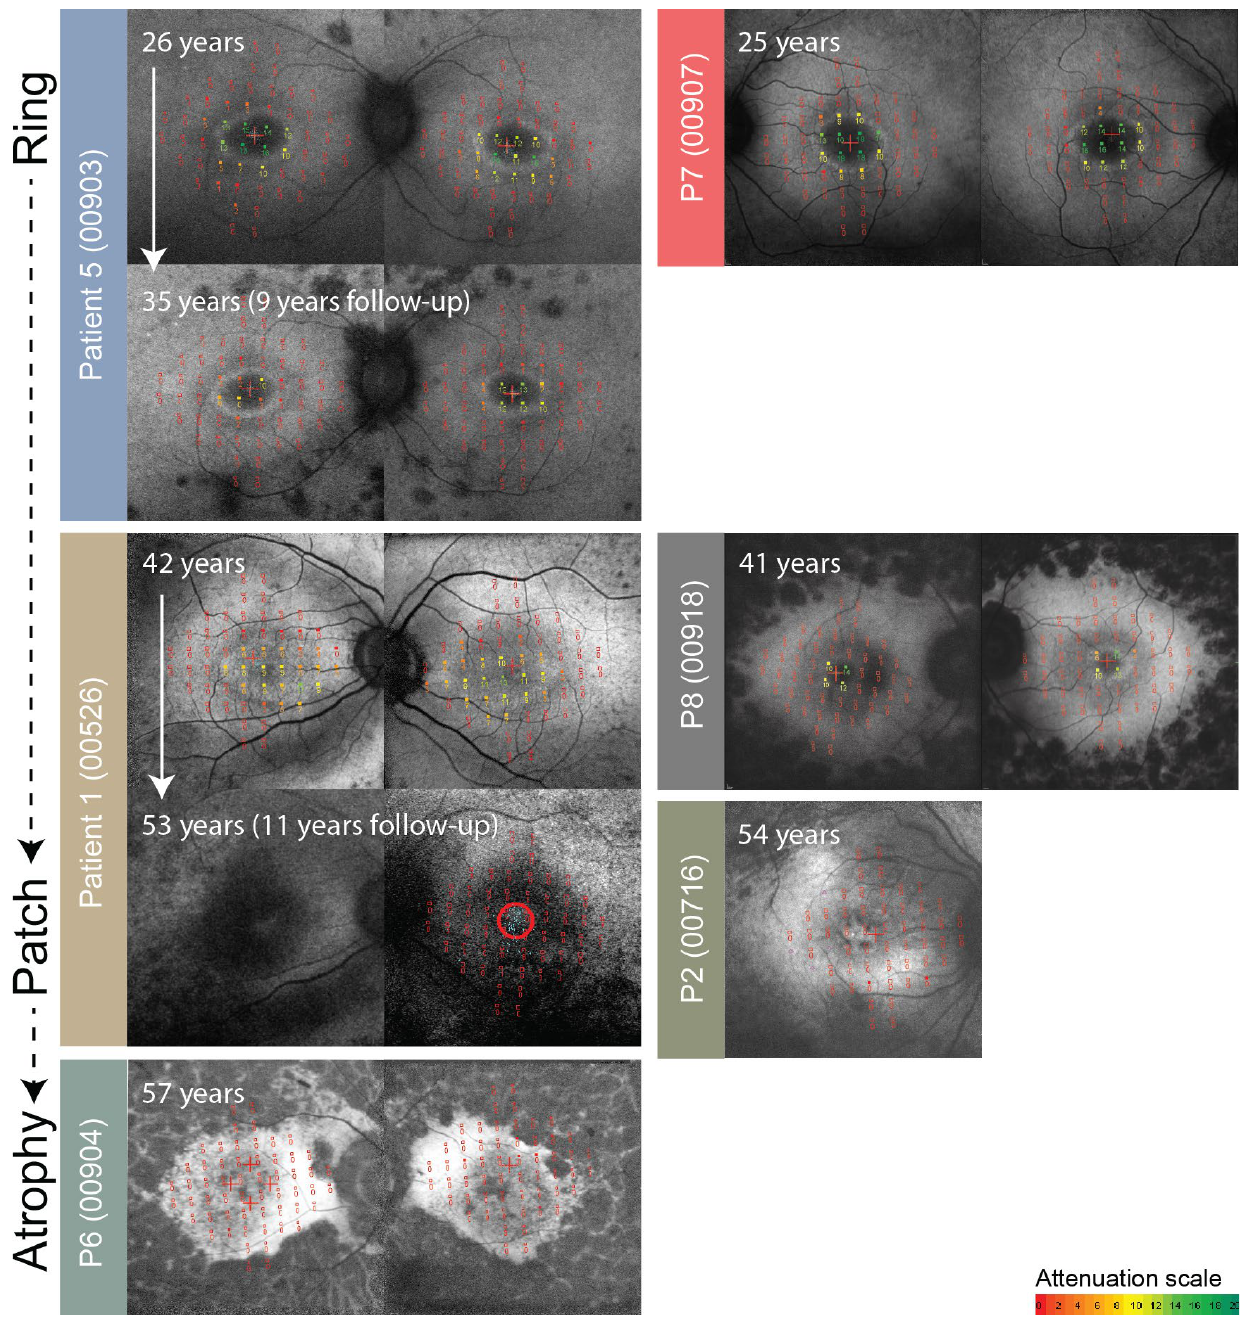
Figure 7. Enlarged FAF with overlaid microperimetry of patients who had p.(Cys870*) in trans with a stop allele. The right eye is shown on the left and the left eye on the right for each patient. Patient ID (center ID) is stated on the left side of each eye pair. Follow-up is shown when available. Microperimetry results are on a color scale from good sensitivity (green) to poor retinal sensitivity (red), with the attenuation scale in dB shown below. The patients are arranged from youngest to oldest in a vertical direction to demonstrate the progression of disease from the early stage (hyperautofluorescent ring) to the advanced stage (patch and atrophy). Note preserved retinal sensitivity inside the hyperautofluorescent ring and severe loss of retinal sensitivity in advanced stages.